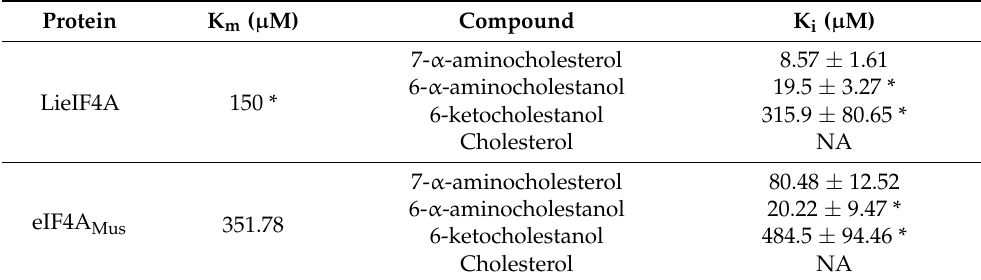
Table 2. Summary of the K i value calculations of the sterol and cholestanol derivatives for LieIF4A and eIF4A Mus .